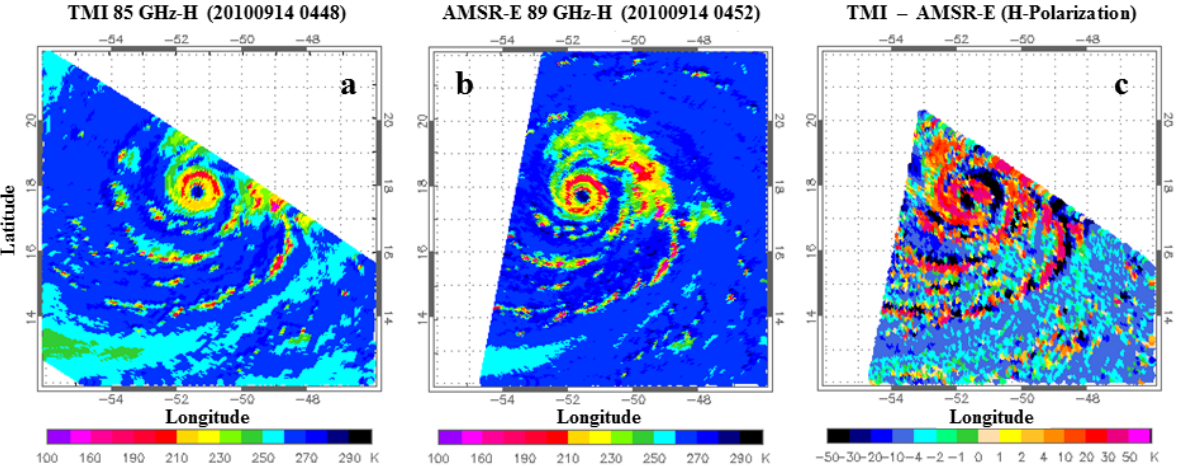
Figure 2. Comparison of TMI and Advanced Microwave Scanning Radiometer for EOS (AMSR-E) T s (K) for hurricane Igor: ( a ) TMI 85 GHz-H pol; ( b ) AMSR-E 89 GHz-H pol; B ( c ) T − T BTMI85h